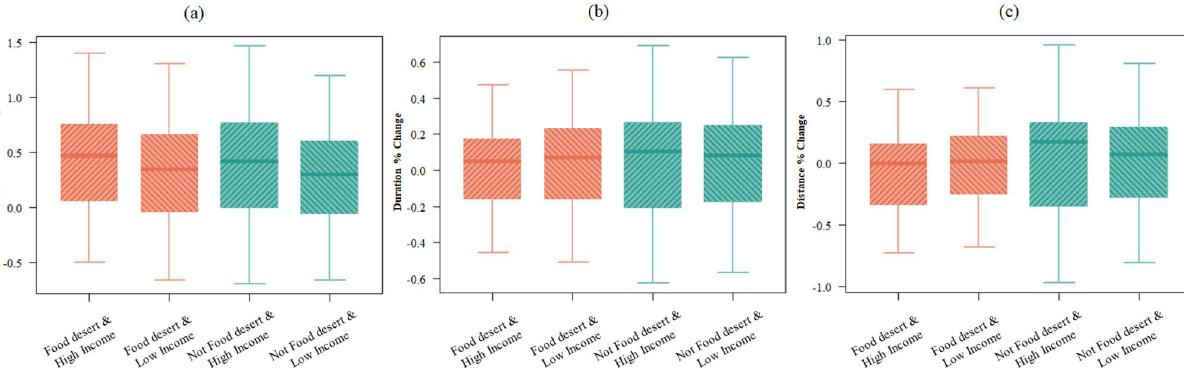
Figure 5. Comparison of the percentage change of the access indicators. These boxplots show the percentage change of the access indicators for the day before the hurricane landfall. The four groups categorized based on food desert status and income show those TAZs with a high income and not located in a food desert have the greatest change in their access indicators during preparedness stage: values for the number of unique visited stores (greater number of visited stores means more access redundancy) ( a ); values for the duration of trips (greater trip duration means less rapidity) ( b ); values for the distance (greater distance means less proximity) ( c ).